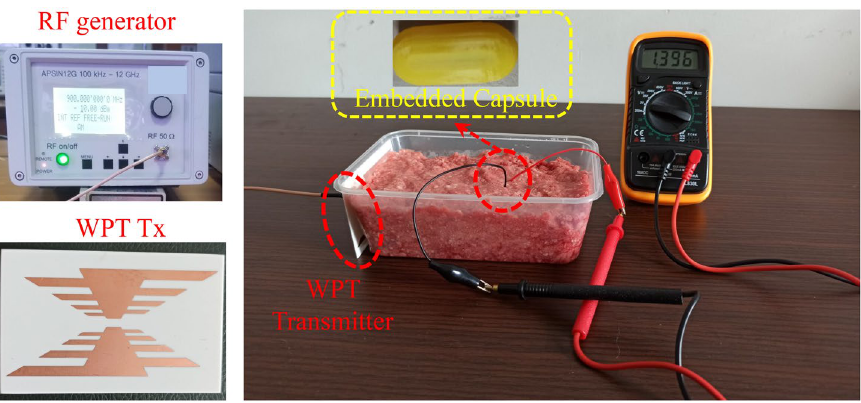
Figure 16. Measurement setup of the rectenna. An RF signal generator is used to source the WPT Tx and output (in terms of voltage) of the rectenna is observed using